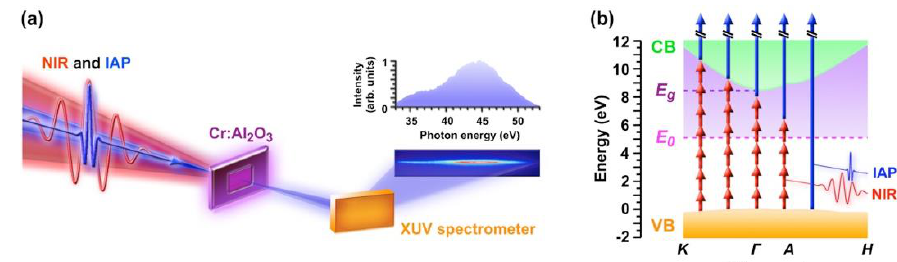
Fig. 1. Experimental setup and energy level diagram of Cr:Al 2 O 3 . (a) Schematic view of the FTXUV. IAP: 192-as duration in the Cr:Al 2 O 3 . NIR pulse: 1.6-eV, 7-fs duration. The targets were Cr:Al 2 O 3 (36-nm-thick) without substrate. The transmitted IAP from the target was detected by the XUV spectrometer. (b) Energy level diagrams of Cr:Al 2 O 3 . The orange, purple, and green shaded areas show the VB, intermediate, and CB states. Bandgap energies E g was 8.7 eV in the Al 2 O 3 host material. The initial intermediate state E 0 with Cr dopant was located at 5.0 eV. The blue and red arrows show the IAP and NIR, respectively.